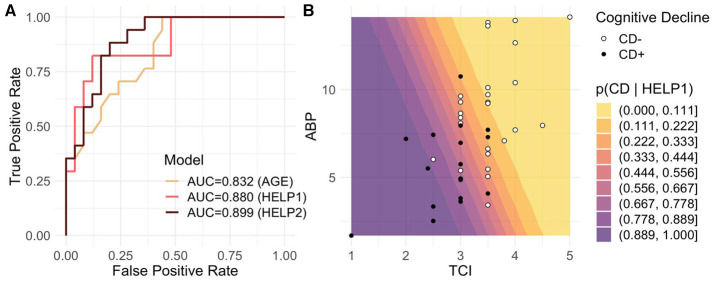
Predicting CD from TCI and AP. We assessed CD prediction based on 3 models including the age (AGE), TCI and AP (HELP1), and the three variables altogether (HELP2). (A) We reported logistic based classification results for the three models in a form of ROC curves with their associated AUC, which were 0.832, 0.880, and 0.899 for AGE, HELP1 and HELP2, respectively. Despite better AUC for HELP2, model comparison showed that (HELP2) does not bring significantly more information than HELP (p = 0.032 vs. 0.064, likelihood ratio test). We therefore selected HELP1 to model the risk of CD occurrence. (B) We investigated the relationship between AP (y-axis), Propofol TCI (a-axis), preoperative MoCA (circles) and the probability to present CD estimated by HELP1 (color gradient). CD+ and CD– patients are depicted by black circles and white circles, respectively. Cold, purple colors indicated high probability to present CD. One can readily see that low MOCA scores were associated with lower TCI and lower alpha power. Some cases are discussed in Figure 4 concerning patients with MoCA and HELP mismatch [white circles in a cold zone, TCI 2.5 μg/ml, AP at 6 db (Figure 4C) and black circles in a warmer zone, TCI 3 μg/ml and alpha band at 10 db (Figure 4D)].